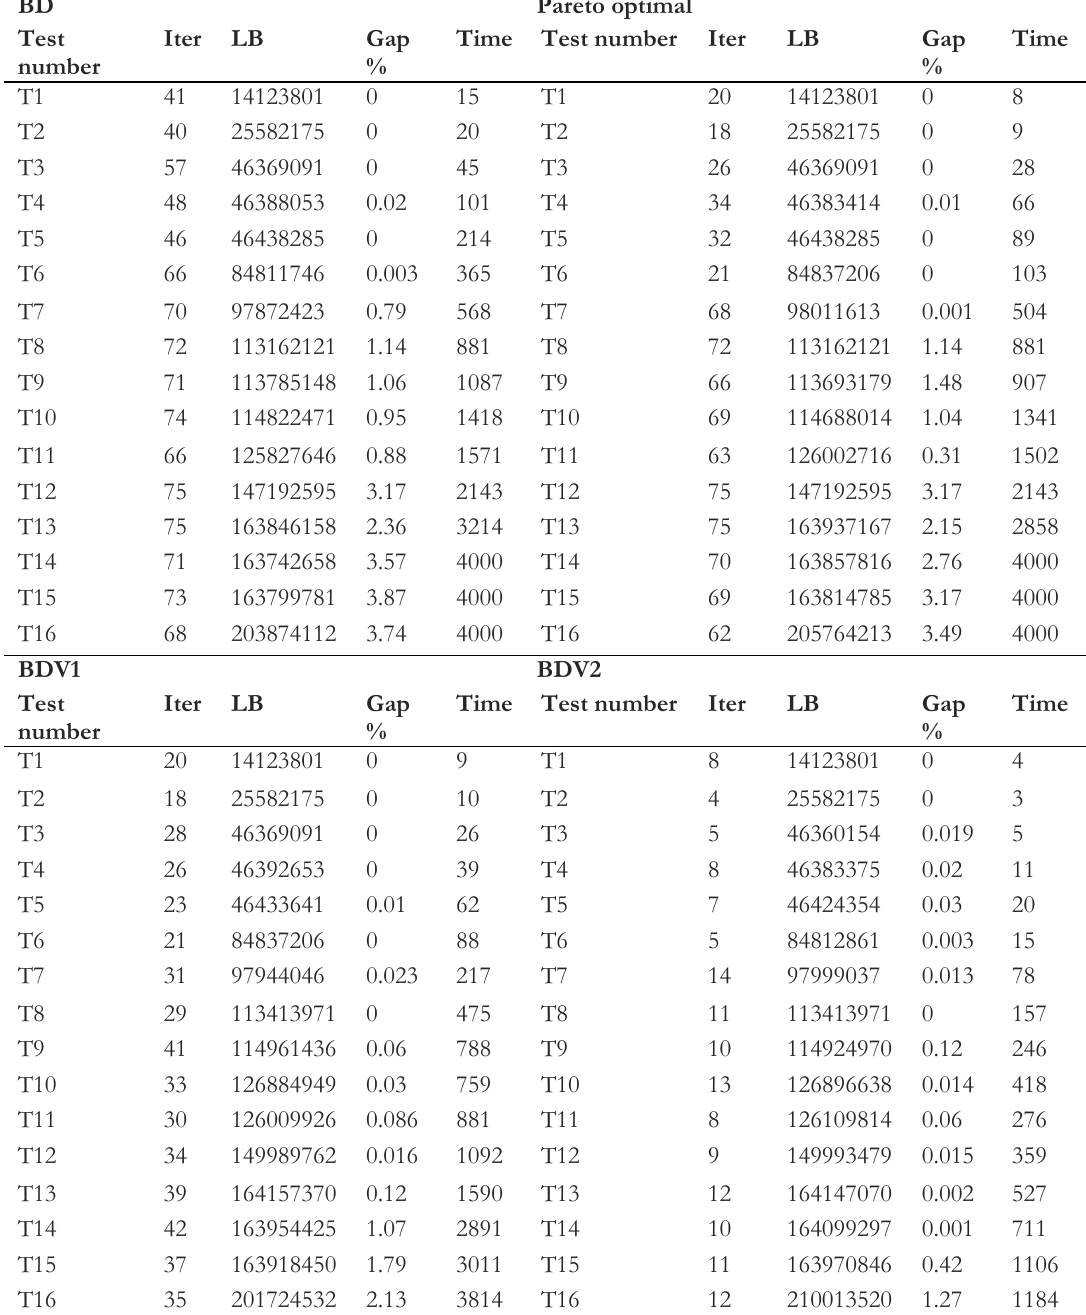
Table 12. Comparison of